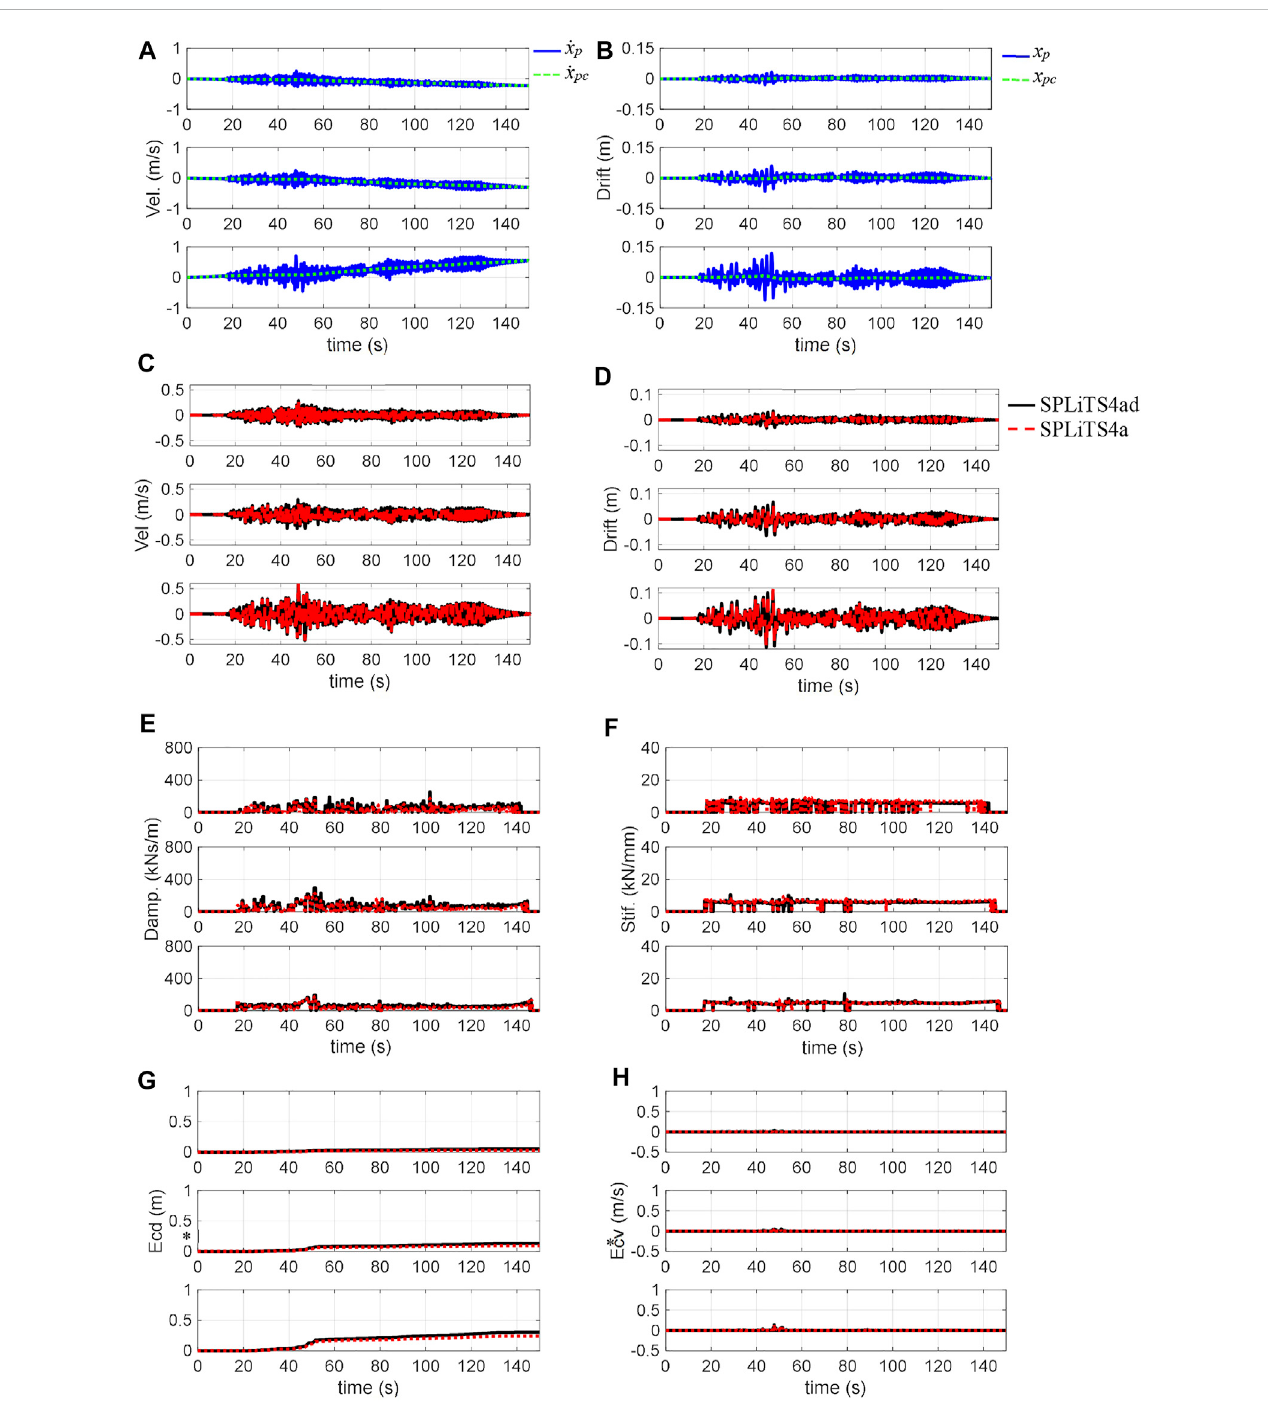
FIGURE 14 Structural responses of 150% Nankai and estimates by SPLiTS: (A) velocity obtained by integration, (B) displacement obtained by integration, (C) velocity with minimised central-point shift components, (D) displacement with minimised central-point shift components, (E) estimated damping, (F) estimated stiffness, (G) structural energy absorption E* cd , and (H) energy absorbing rate E* cv . N.B.: The top, middle and bottom in each fi gure corresponds to third, second, and fi rst storeys,